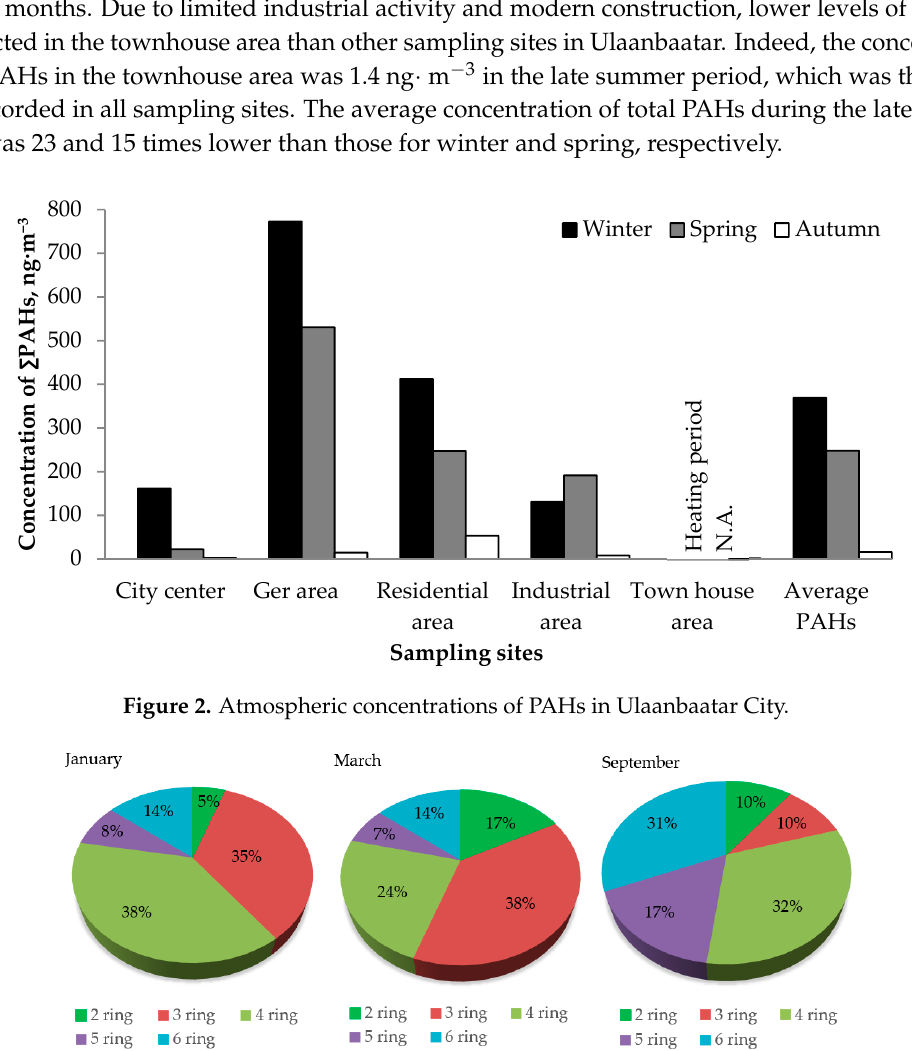
Figure 3. Fractions of PAHs with different ring numbers .